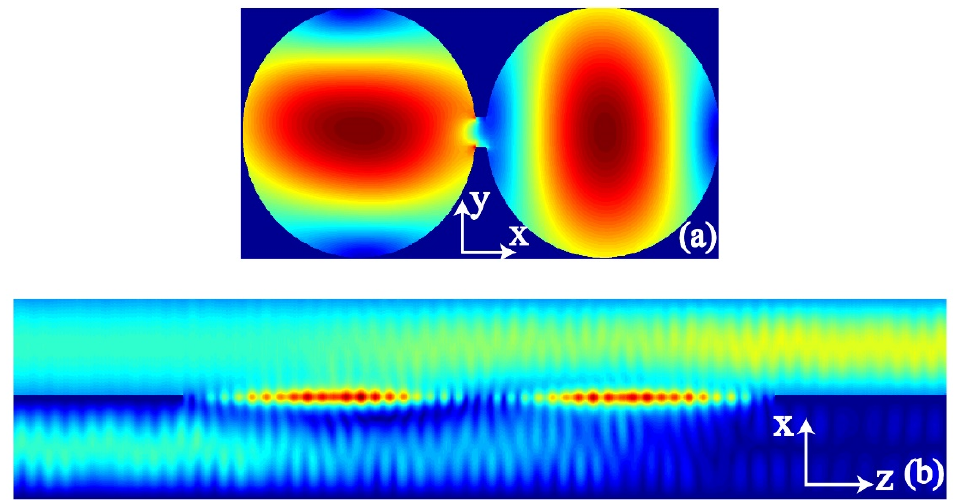
Figure 4. Horizontal and vertical polarization wave simultaneously inputting: ( a ) coupling slot structure direction and the transverse electric field and ( b ) longitudinal electric field (XZ cross section).